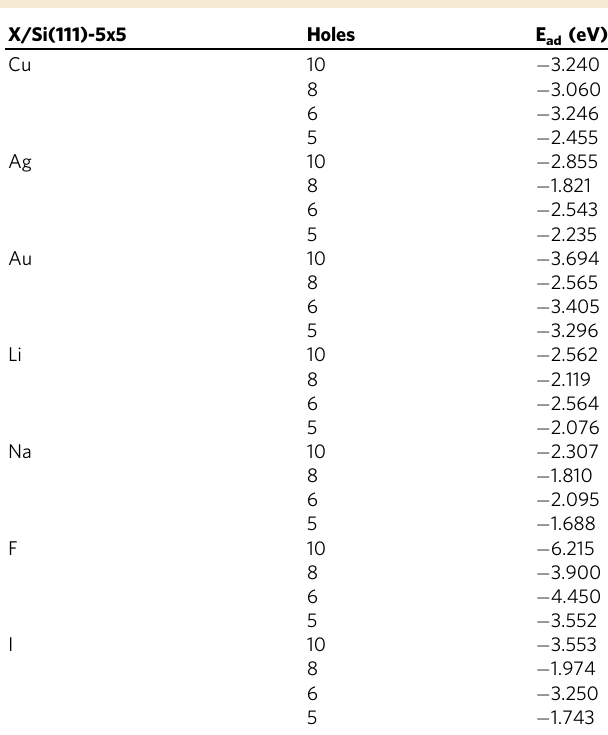
Table 1 The adsorption energies of Cu, Ag, Au, Li, Na, F, and I on the Si(111)-5×5